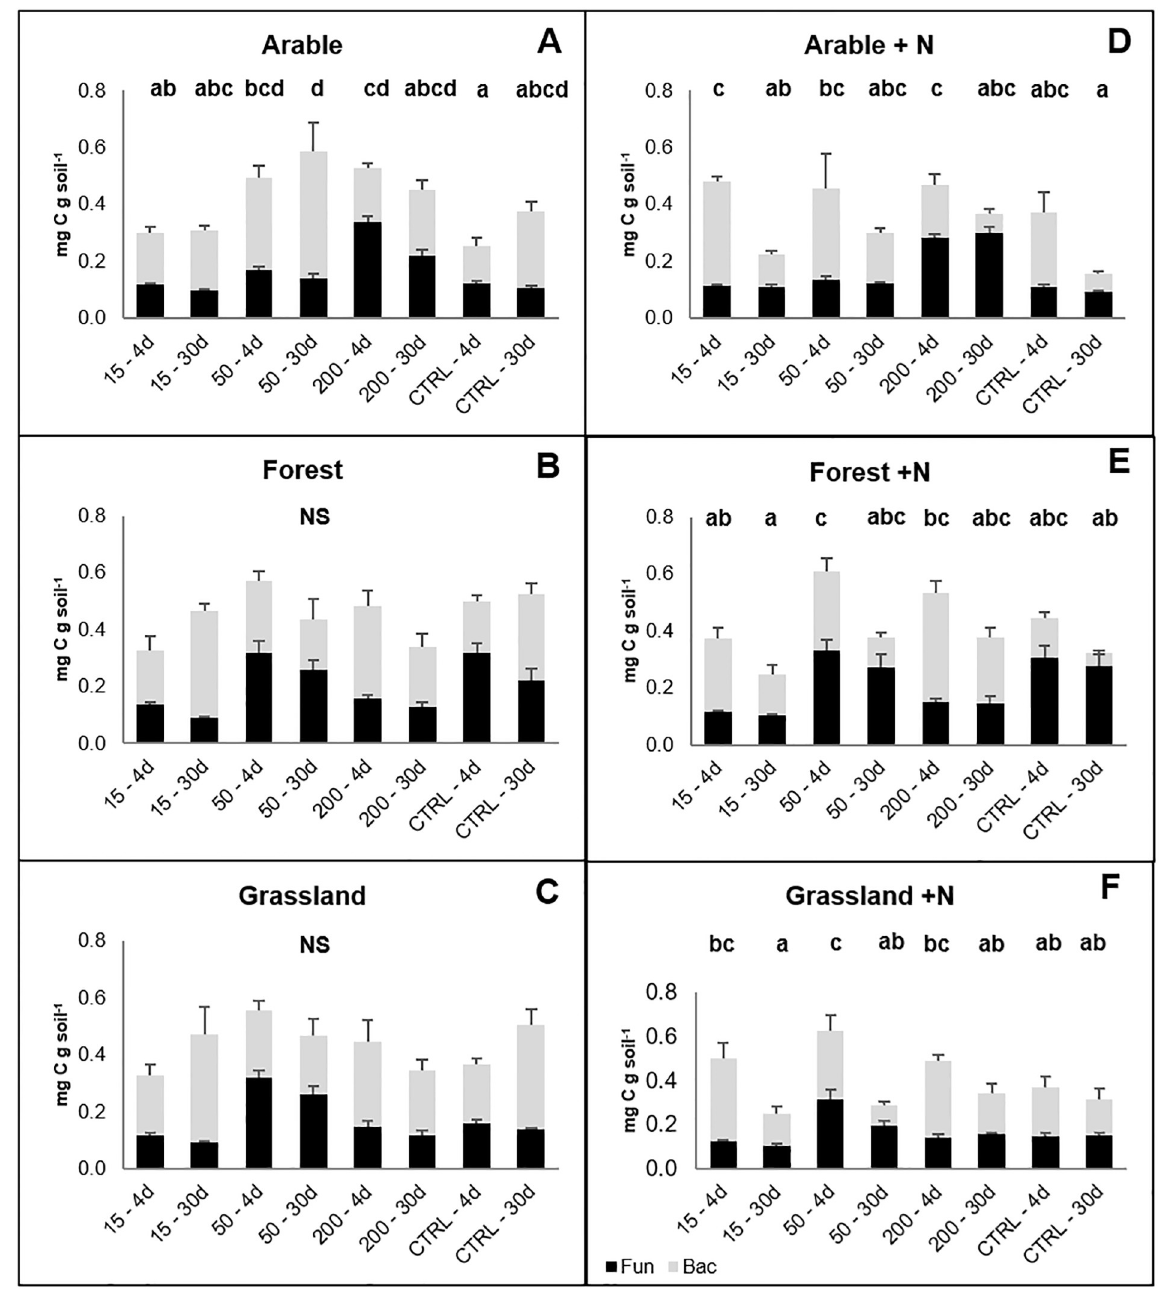
Fig 4. Microbial biomass (fungi + bacteria, mg C g dw soil -1 ) measured at 4 and 30 days of incubation of glucose-amended soils obtained from three ecosystems. Fungal and bacterial biomass are estimated on basis of ergosterol (fungal) and qPCR-16SrDNA (bacteria). 15, 50 and 200 indicate the quantity of glucose-C added representing 15%, 50%, and 200% of the initial microbial biomass carbon. 4d: fourth day of incubation. 30d: thirtieth day of incubation. CTRL: control treatment. N: NH 4 NO 3 . Statistically significant differences (P < 0.05) are marked with different letters. NS: no significant differences. Error bars represent standard errors (n = 4). Black columns: fungal biomass. Grey columns: bacterial biomass. Two-way ANOVA results are reported in S3 Table.